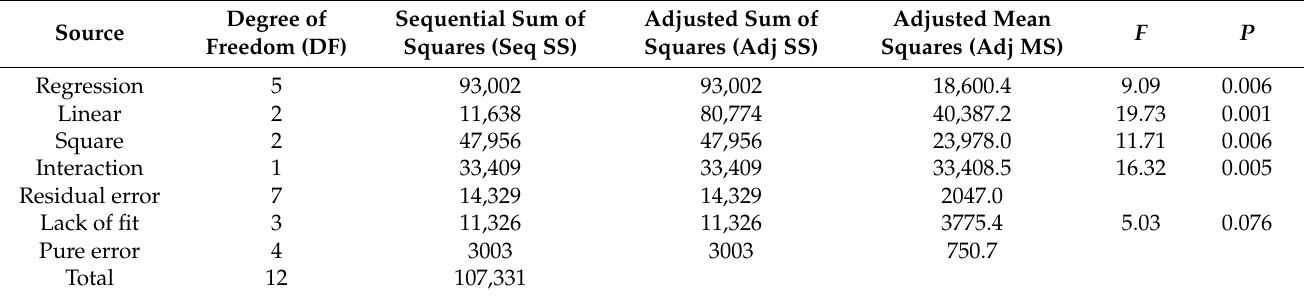
Table 7. ANOVA results for the response surface quadratic model of the human TNF- α cell-free synthesis.